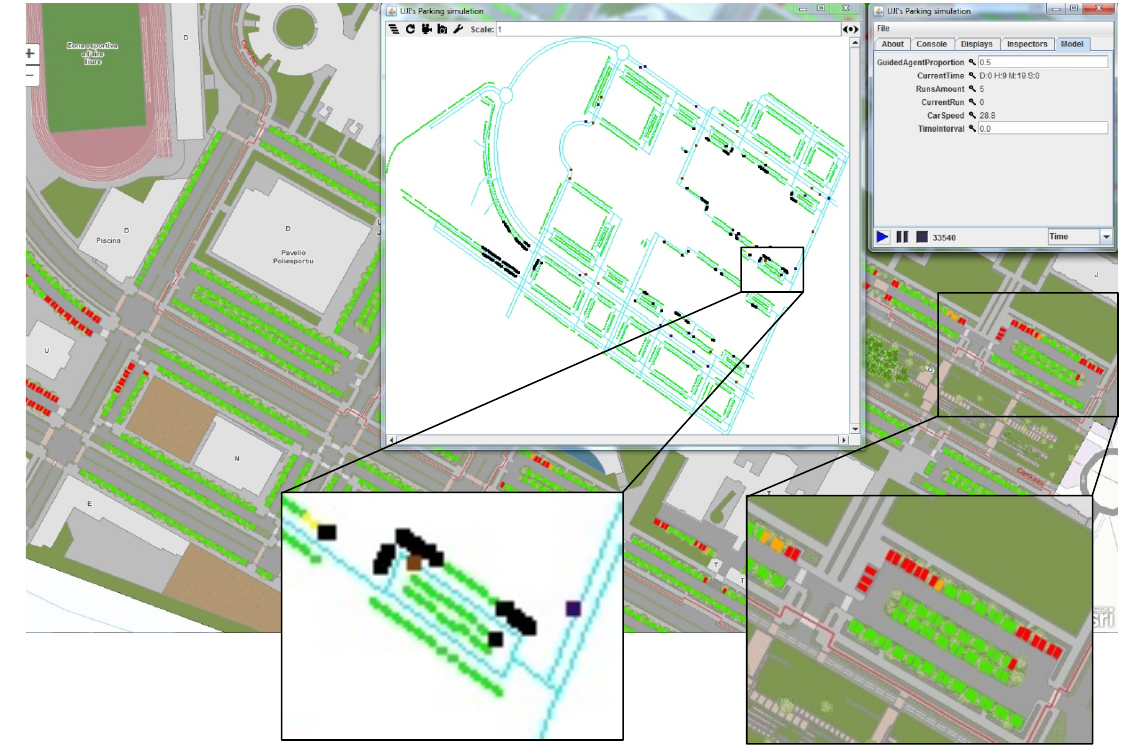
Figure 3. One of the simulator applications running in the foreground, while in the background a web map shows the parking spots’ current status as stored in the SPS. In the simulator, black squares represent parked agents. In the web map, red squares represent occupied parking